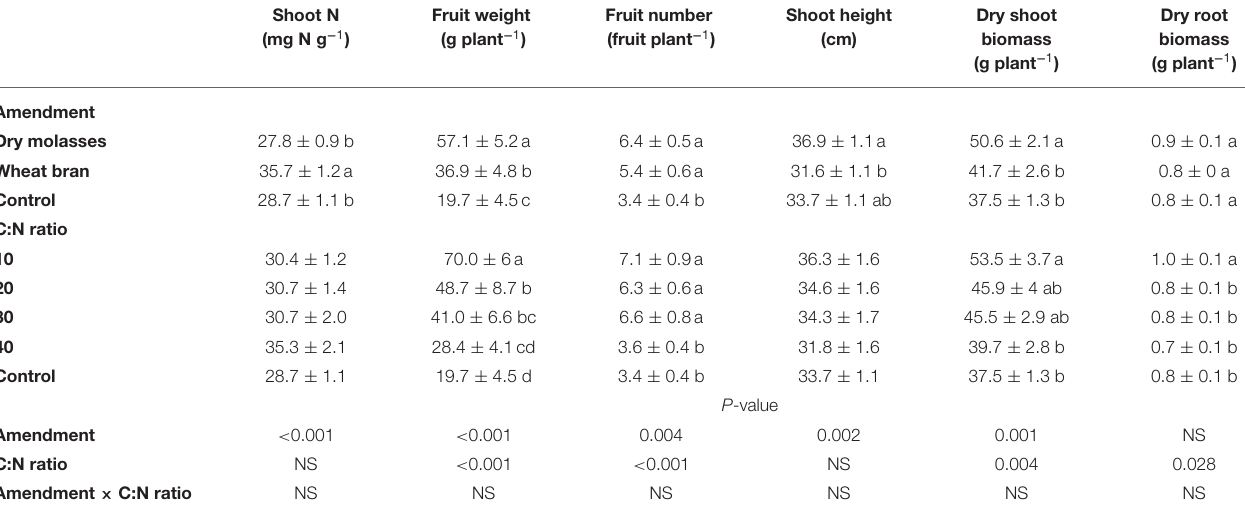
TABLE 5 | Mean values by main effects and analysis of variance for growth characteristics tomato plant 8-week post termination of ASD treatment as affected by carbon amendment, C:N ratio and the interaction in trial